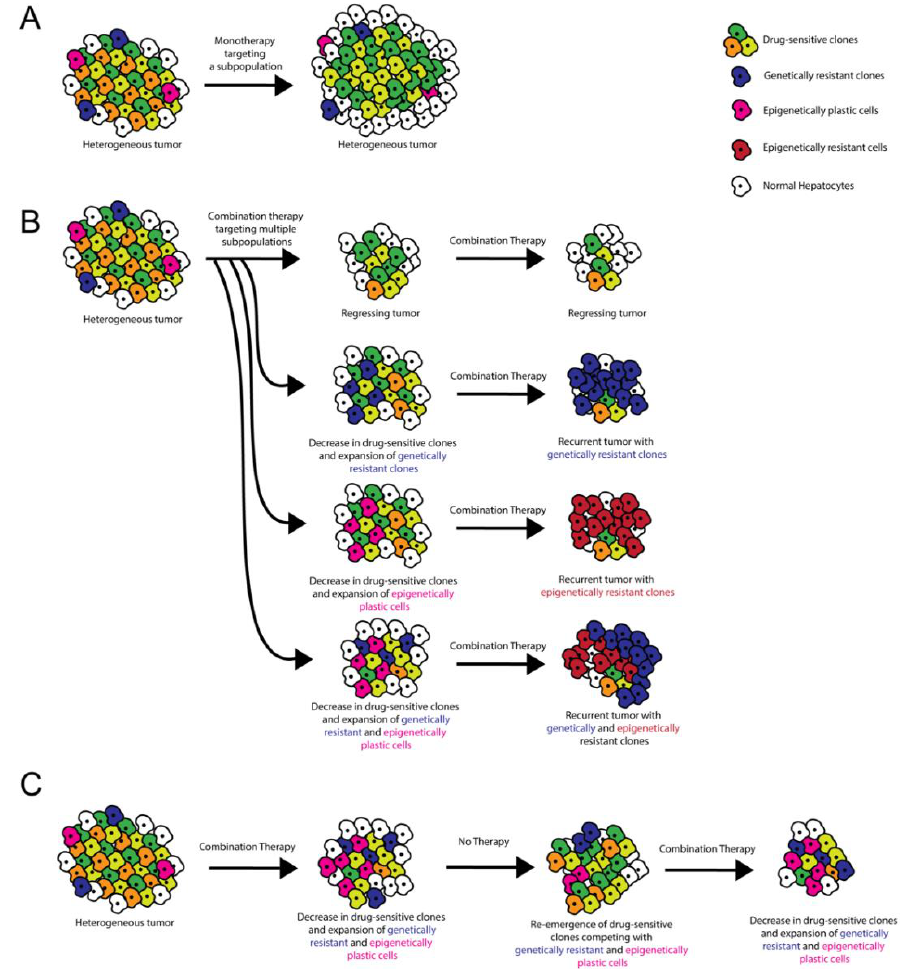
Figure 2. Role of ITH in targeted therapy resistance and treatment stratagem. ( A ) Monotherapies target a subset of tumor cells, resulting in incomplete tumor attrition. ( B ) Combination therapies target multiple oncogenic pathways, potentially resulting in tumor regression. However, recurrent tumors can occur when pre-existing ITH or ITH induced by cell–cell/cell–microenvironment interactions results in the emergence of genetically and/or epigenetically resistant clones. ( C ) Combination therapy administered with alternating periods without treatment allows for the disappearance and re-emergence of drug-sensitive clones. Competition between clones limits the emergence of resistant clones.